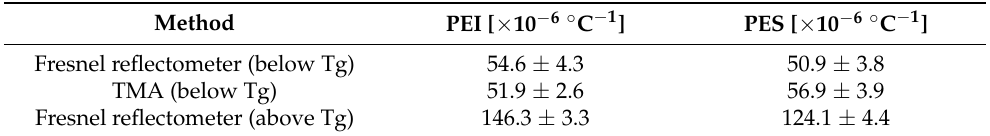
Table 1. Linear CTEs derived from the Fresnel reflectometer below and above the glass transition temperature (Tg) and TMA below